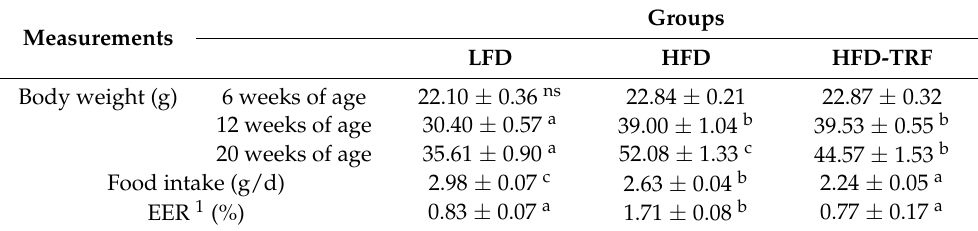
Table 1. Body weight, food intake, and energy efficiency ratio.